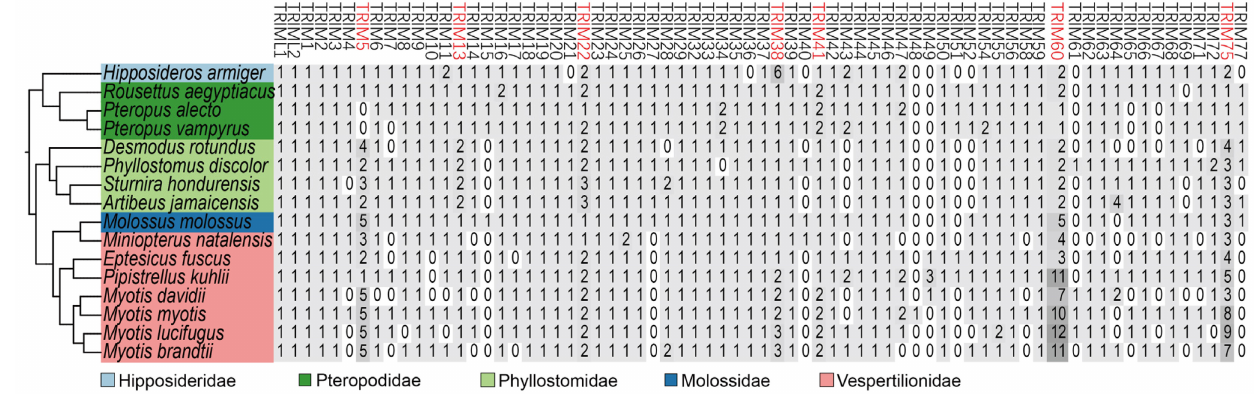
Figure 1. Number of bat TRIM family members. The bat phylogeny tree was generated using data from a previous study [33]. The background color is proportional to the corresponding copy number. The duplicated TRIM family members are marked in